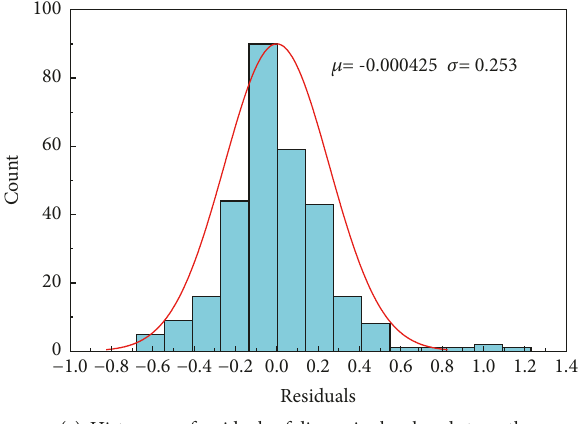
Figure 3: Dimensionless bond strength of pull-out specimens with deformed rebar (no stirrups): (a) dimensionless bond strength versus corrosion level; (b) residuals versus corrosion level; (c) histogram of residuals of dimensionless bond